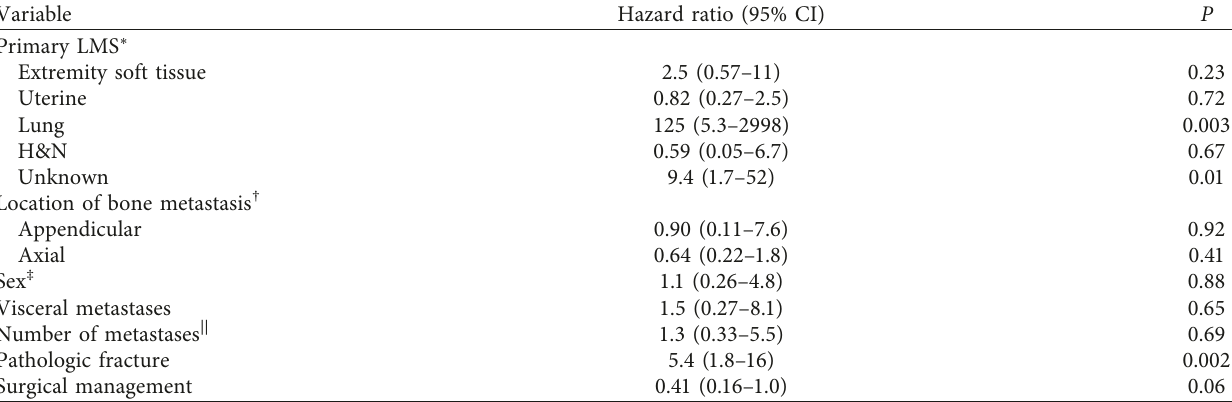
Table 5: Cox regression analysis of survival in 45 patients with metastatic leiomyosarcoma to the bone.